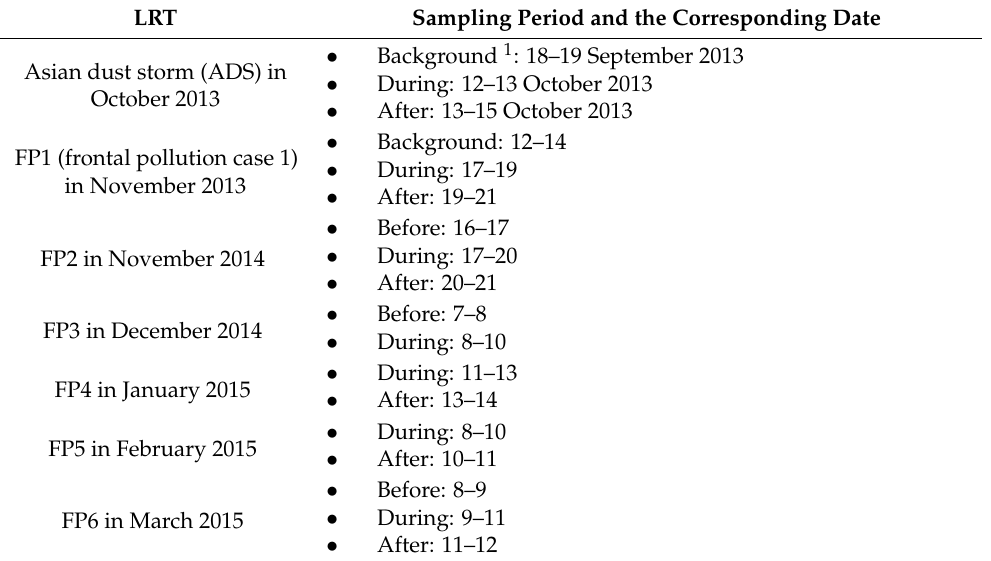
Table 1. Long-range transport (LRT) events from September 2013 to April 2015. LRT Sampling Period and the Corresponding Date Asian dust storm (ADS)